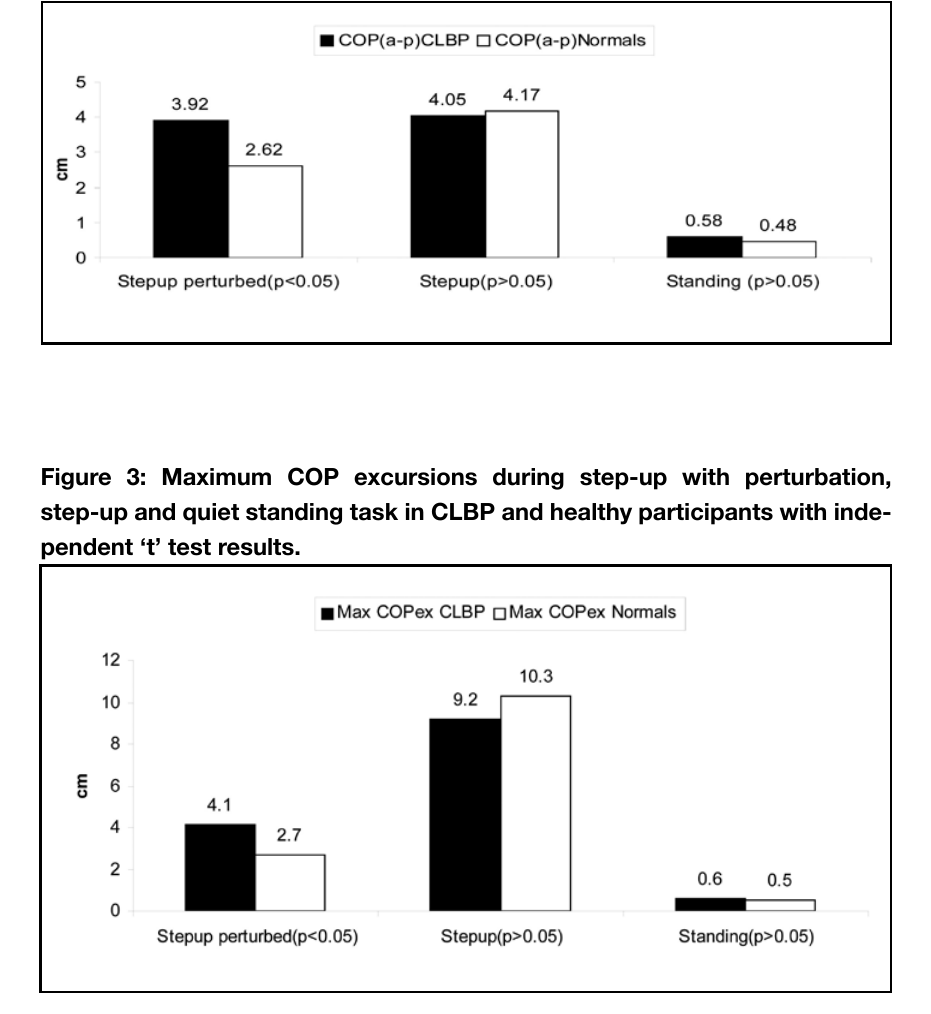
Figure 2: coP (Antero-posterior) excursions during step-up with pertur- bation, step-up and quiet standing task in clBP and healthy participants with independent ‘t’ test